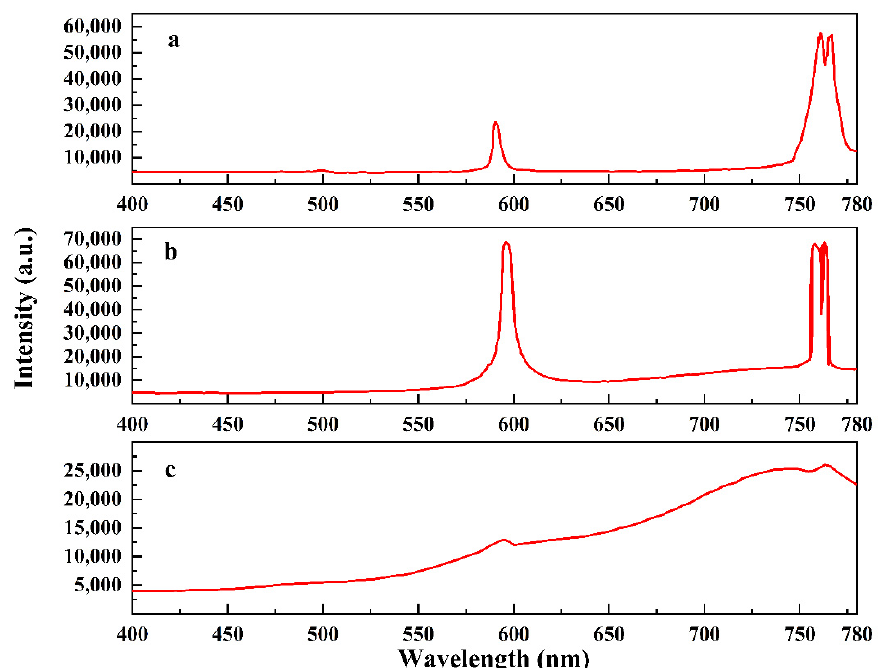
Figure 7. Illuminant, combustible illumination shell, and resin pillar combustion radiation spectrum: ( a ) illuminant; ( b ) combustible illuminant shell; ( c ) resin pillar.